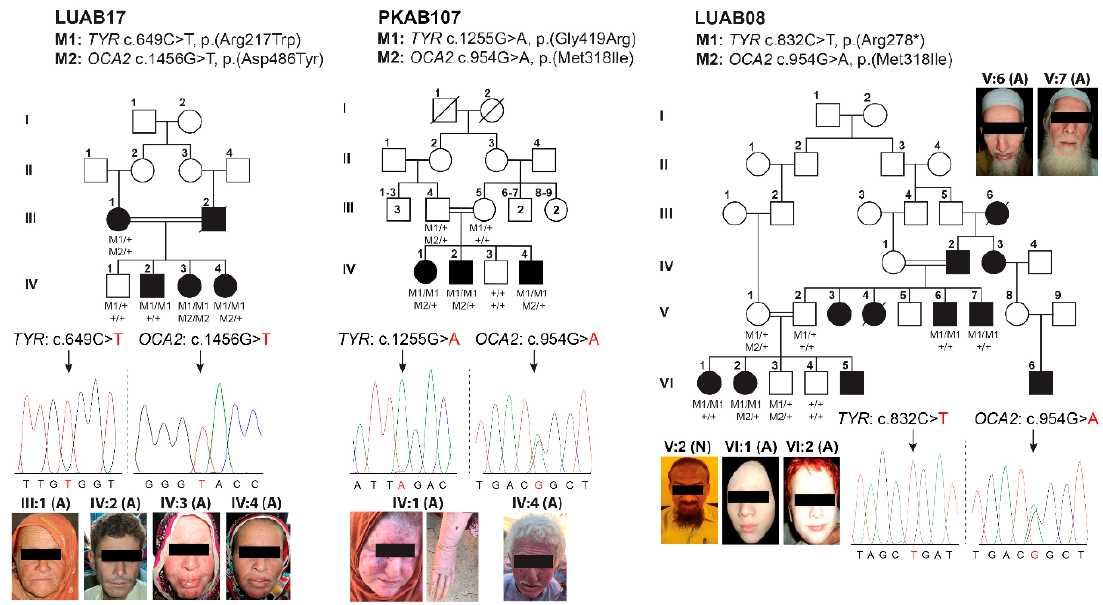
Figure 2. Family pedigrees of Pakistani OCA families with multi-gene variants are shown. Genotypes are mentioned below each sequenced individual, while the identified variants and gene names are listed on top of each pedigree. Empty and filled symbols represent the normal and affected individuals, respectively. A double line between two individuals represents a consanguineous marriage. Sequenced chromatograms of the affected individuals along with photographs are displayed below pedigrees with the cDNA change mentioned in red color.